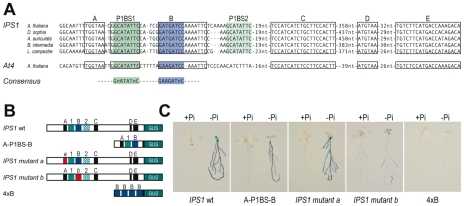
Phylogenetic footprinting and mutational analysis of the IPS1 promoter.(A) Alignment of the promoter region of IPS1 from five Brassicaceae species (Arabidopsis thaliana, Descurainia sophia, Brassica intermedia, Arabis auriculata and Lepidium campestre), which is conserved in the highly related At4 gene. A consensus sequence is shown indicating conservation of P1BS closely linked to motif B in the promoter of more distant IPS1-related genes from Arabidopsis and from other species (Medicago truncatula, Solanum lycopersicum, Populus trichocarpa and Zea mays). Conserved regions between IPS1 orthologs and At4 are boxed; the P1BS1 and B motifs conserved in distantly related IPS1 family members are shown in green and blue, respectively. The P1BS2 motif conserved only among IPS1 orthologues is highlighted (pale green). (B) Diagram shows different IPS1 promoter-derived reporter constructs: wild type 1 kb IPS1 promoter region (IPS1 wt), including P1BS (green boxes), motif B (blue box) and motifs A, C, D and E (black boxes); a 42-bp IPS1 promoter fragment (A-P1BS-B), including motifs A, P1BS1 and B; four tandem copies of motif B (4xB). Both A-P1BS-B and 4xB were fused to the −46 minimal promoter from the CaMV 35S gene fused to the coding region of the GUS reporter; versions of the IPS1 promoter with either motif A or motif B mutated (red boxes) were fused to the coding region of the GUS reporter. (C) Histochemical analysis of GUS activity driven by wild type IPS1:GUS and derived reporter constructs. Plants were grown for 7 days in +Pi or −Pi media.